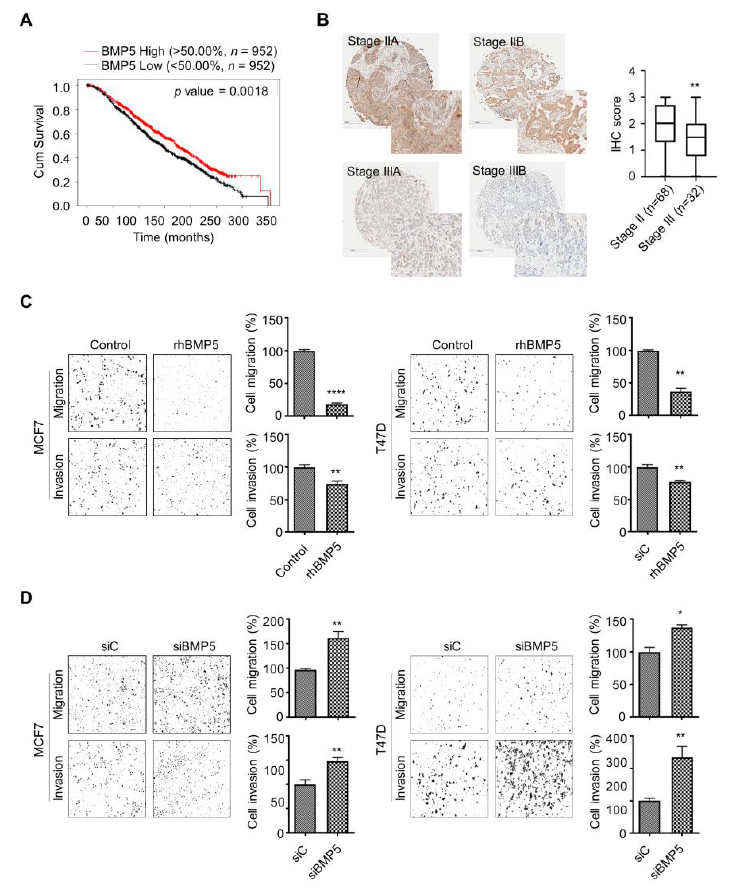
Figure 4. BMP5 contributes to reduce migration and invasion abilities of tumor cells. ( A ) Low BMP5 expression is associated with poor survival outcomes of breast cancer patients. ( B ) Patients with stage 3 disease showed higher BMP5 levels than those of stage 2 patients. ( C , D ) Migration/invasion abilities were decreased by treatment of recombinant BMP5; however, the capabilities were enhanced following BMP5 downregulation. p values were calculated using ANOVA. * p < 0.05, ** p < 0.01, **** p < 0.0001.